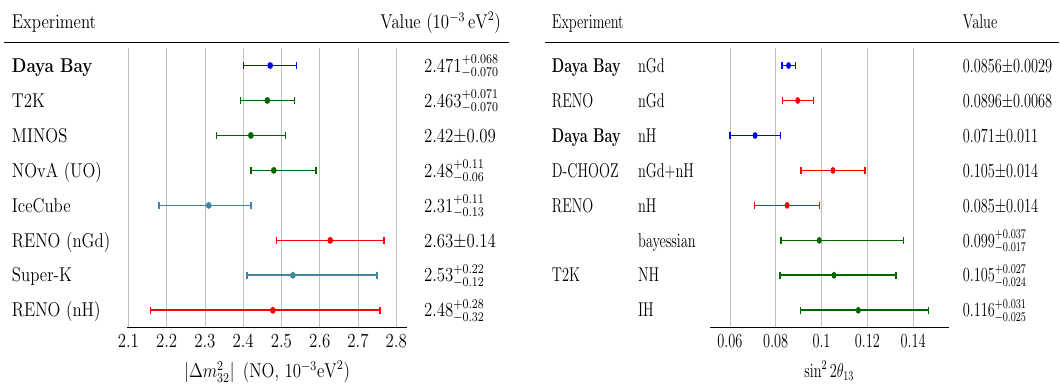
Figure 1. Values for the oscillation parameters recovered by the three main present SBL reactor experiments, compared with the results by the LBL accelerator experiments and by SuperKamiokande atmospheric neutrino studies. The ∆ m 2 values refer to the normal ordering case. For Daya-Bay 32 and RENO experiments the data set relatives to neutrons (emitted in the inverse β decay) captured by gadolinium (labelled as nGd) [51,53] are reported together with the ones obtained with neutrons captured by hydrogen (labelled as nH) [58,59]. For Double Chooz the data reported refer to the analysis including the total neutron capture detector [52]. Figure obtained by courtesy of M. Gonchar and similar to the one present in